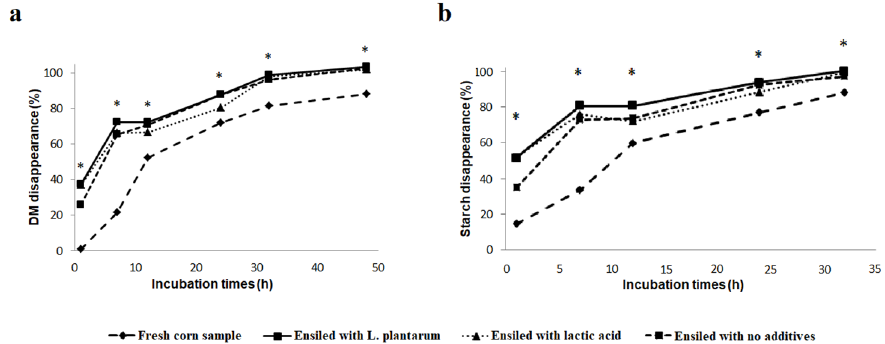
Figure 2. In vitro disappearances of DM ( a ) and starch ( b ) in the fresh corn and high-moisture corn samples. Incubation time points marked with an asterisk show significant differences between treatments ( p < 0.05).